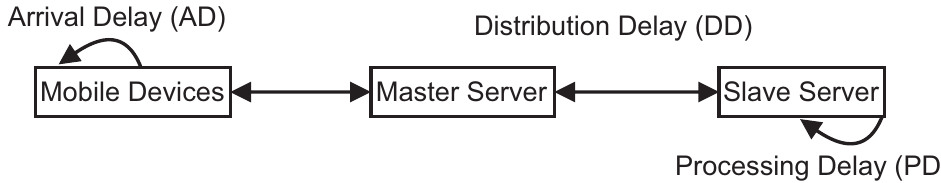
Figure 2. Communication Time Intervals for the Architecture Components. (adapted from